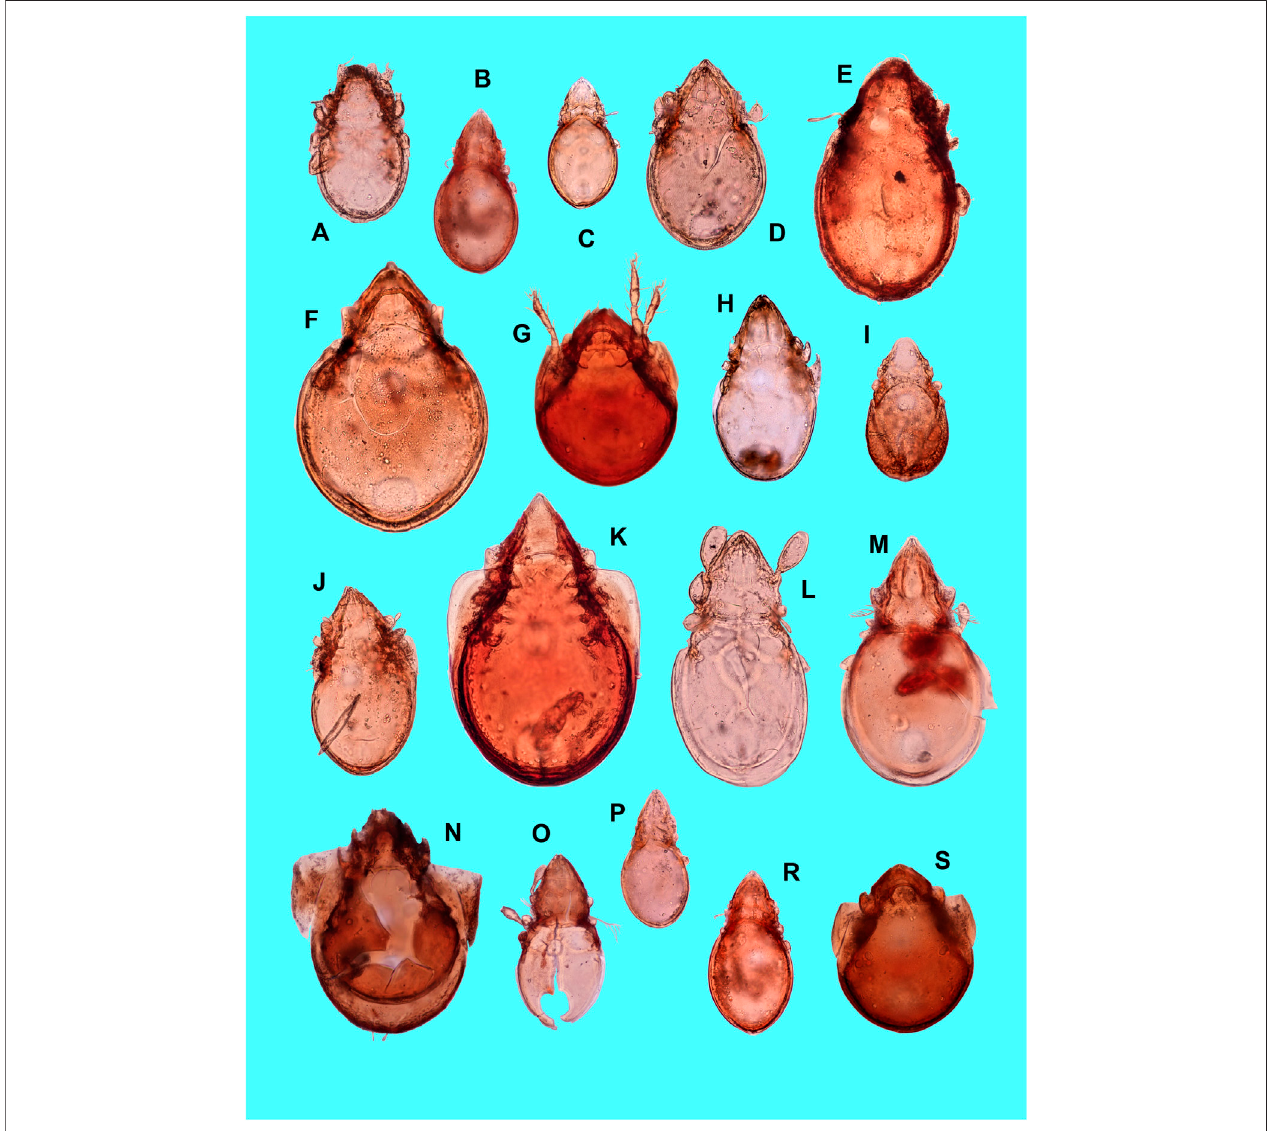
FIGURE 6 | Some of the identi fi ed oribatid fossils in Z ă ton Lake sediments. (A) Tectocepheus velatus; (B) Oppiella nova; (C) Dissorhina ornata; (D) Zygoribatula exarata; (E) Scutovertex minutus; (F) Zygoribatula undulata; (G) Punctoribates hexagonus; (H) Protoribates monodactylus; (I) Micreremus brevipes; (J) Liebstadia pannonica; (K) Scheloribates laevigatus; (L) Eueremaeus sp. ; (M) Ctenobelba sp. ; (N) Peloptulus phaenotus; (O) Ramusella insculpta; (P) Con fi noppia con fi nis; (R) Oppiella uliginosa; (S) Punctoribates punctum.